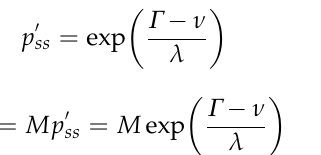
Figure 7. Modified collapse surface from the peak states of ICU results.